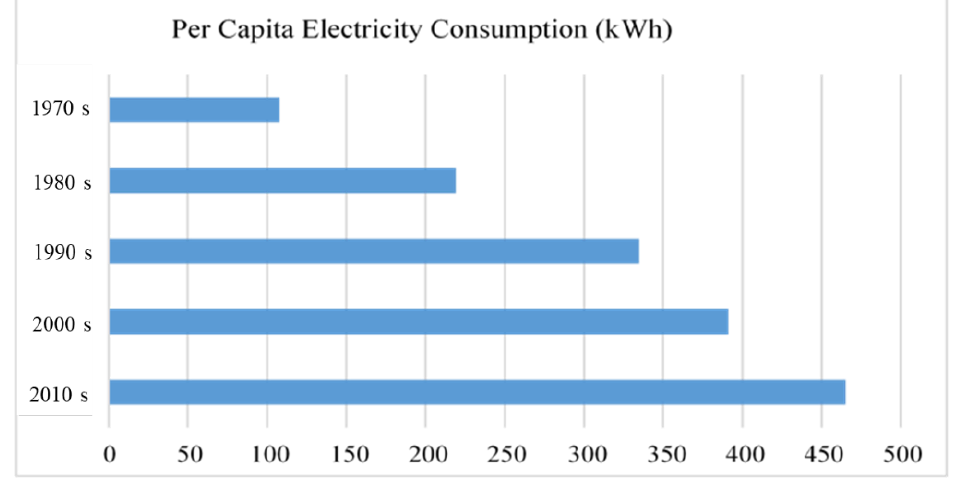
Figure 4. Decade Wise Comparison of Electricity Consumption per Capita (KWh). Data Sources: Pakistan Economic Survey 2009-10 & World Bank.